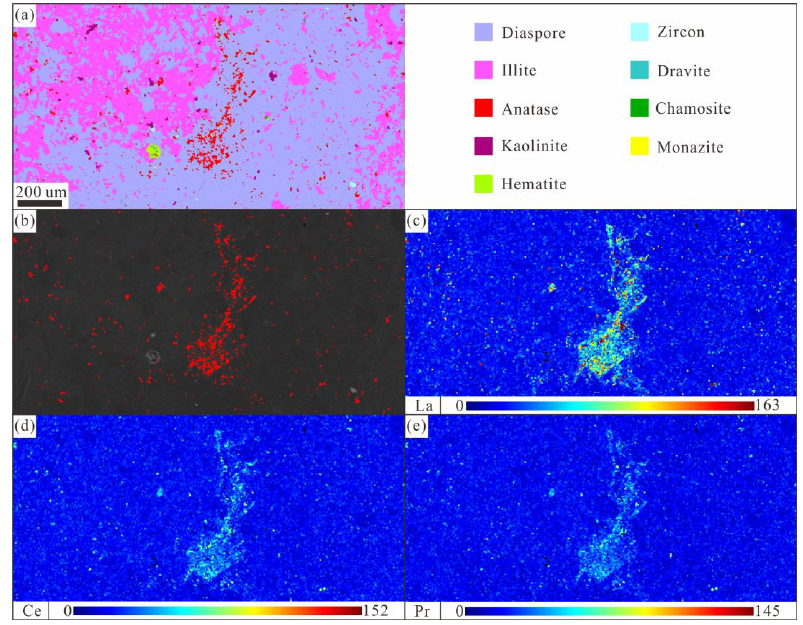
Figure 11. TIMA mineral and REE scanning maps of the representative Lindai bauxite ores. ( a ) All minerals; ( b ) anatase; ( c ) La element; ( d ) Ce element; ( e ) Pr element.